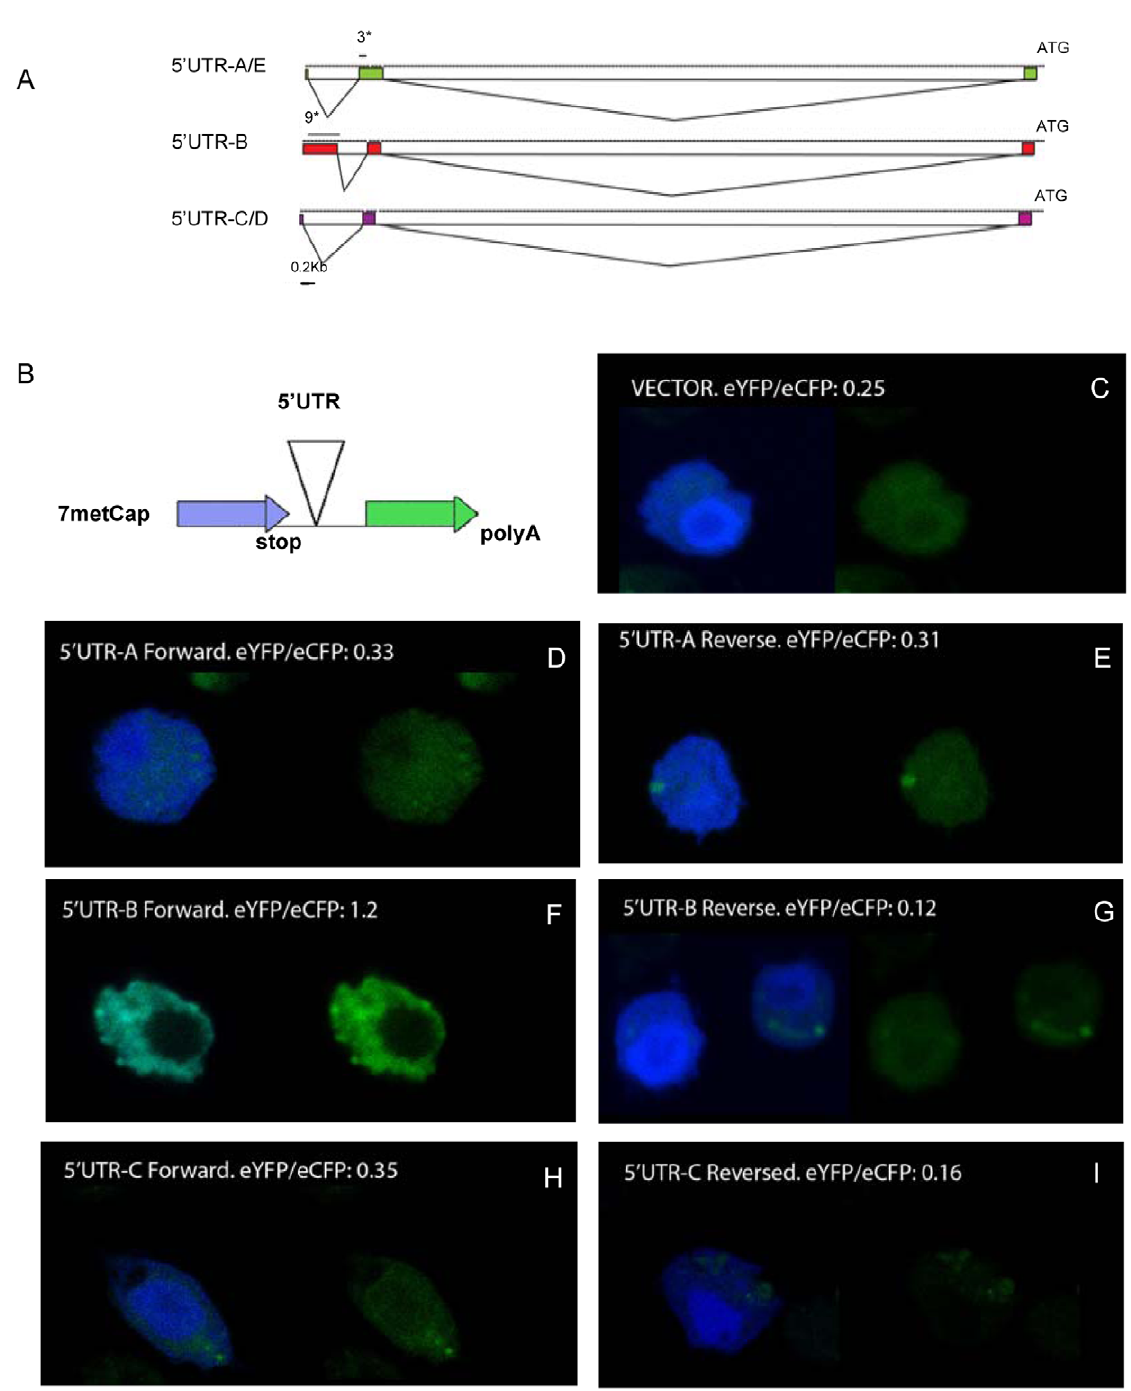
Figure 2. ThedfoxO 5 9 UTR contains IRES. ( A ) Diagram of the genomic region of predicted dfoxO’s 5 9 UTRS. 5 9 UTR-A and -E are similar (5 9 UTR-E has an additional 20 bp located at the 5 9 end). These sequences each contain three upstream ATGs (location marked as 3*). 5 9 UTR-B is the longest 5 9 UTR and with 9 upstream ATGs (location marked as 9*). 5 9 UTR-C and -D are identical and have no upstream ATG. ( B ) Scheme of the di-cistronic reporter construct. Enhanced cyan fluorescent protein (eCFP) in blue and enhanced yellow fluorescent protein (eYFP) in green. ( C–E ) Drosophila S2 cells transfected with eCFP/eYFP di-cistroninc reporter. ( C ) empty vector ( D ) vector with dfoxO 5 9 UTR-A in forward 5 9 -3 9 orientation, ( E ) and vector dfoxO 5 9 UTR-A in reverse 3 9 -5 9 orientation. ( F ) vector with dfoxO 5 9 UTR-B in forward 5 9 -3 9 orientation, ( G ) and vector dfoxO 5 9 UTR-B in reverse 3 9 - 5 9 orientation. ( H ) vector with dfoxO 5 9 UTR-C in forward 5 9 -3 9 orientation, ( I ) and vector dfoxO 5 9 UTR-C in reverse 3 9 -5 9 orientation. The ratios eYFP to eCFP fluorescence are shown above the pictures.